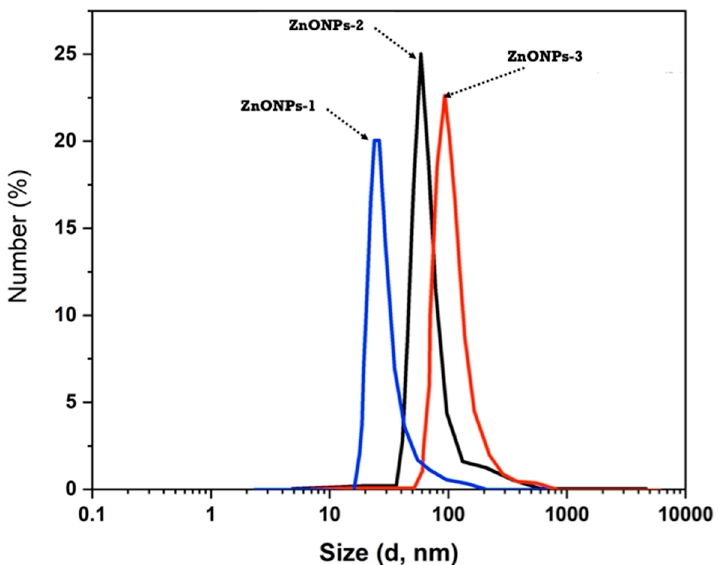
Figure 4. Particle size analysis of ZnONPs-1, ZnONPs-2 and ZnONPs-3.